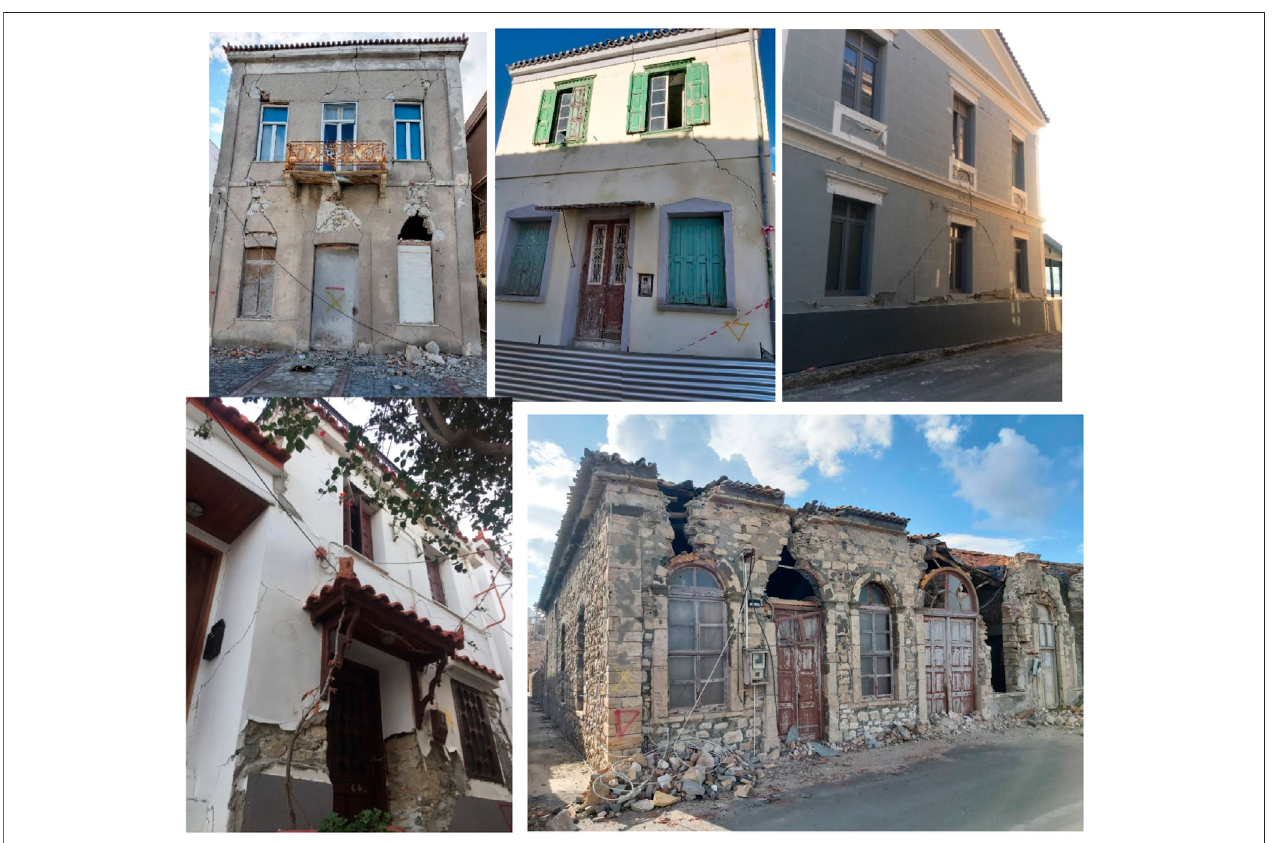
FIGURE 6 | Examples of in-plane failure in masonry structures (all in Samos,